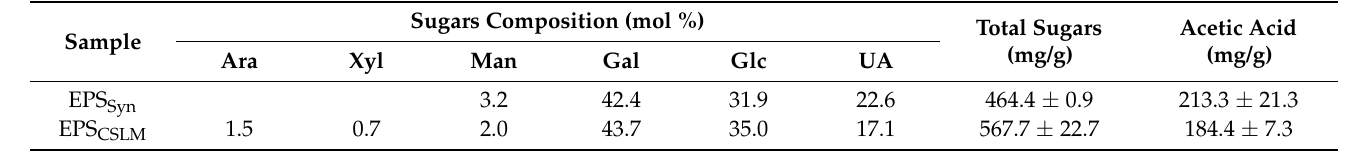
Table 2. Sugars composition of polysaccharides produced by Rhizobium viscosum CECT908 grown